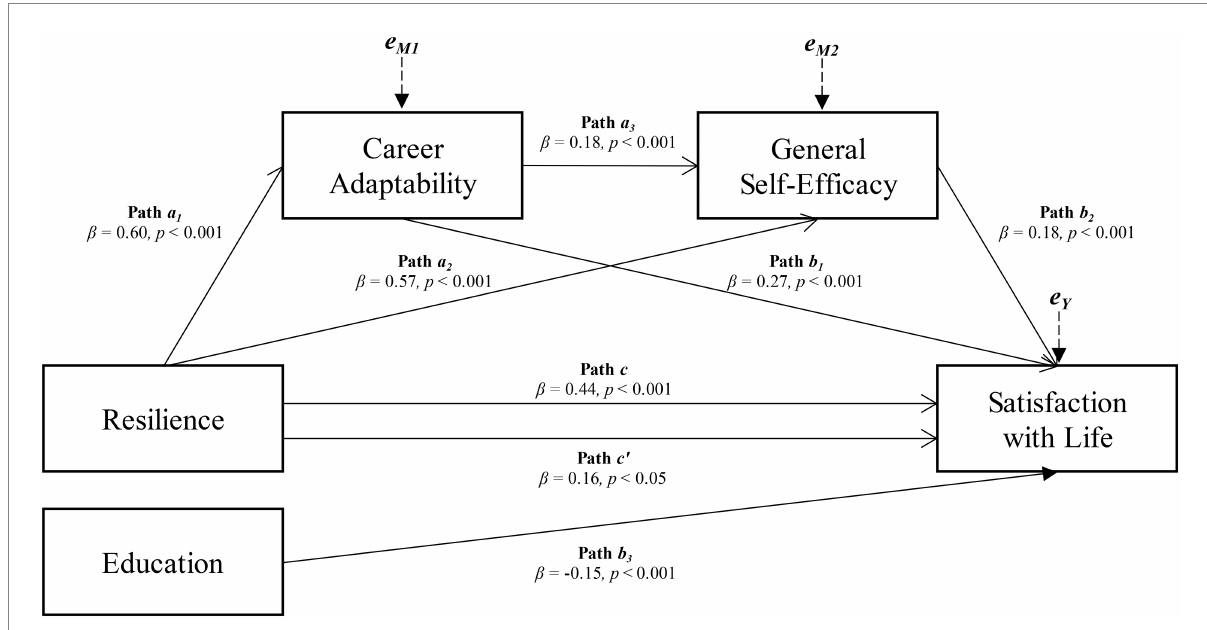
FIGURE 1 The chained mediation of Career Adaptability and General Self-Efficacy in the relationship between resilience and Satisfaction with Life, controlling for education.